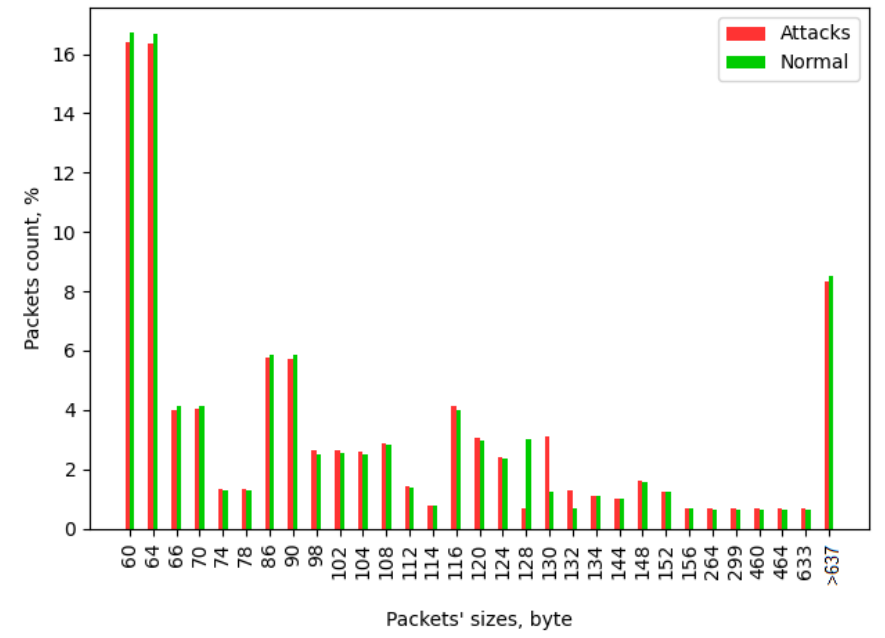
Figure 5. Distribution of the packet lengths for normal and abnormal traffic.